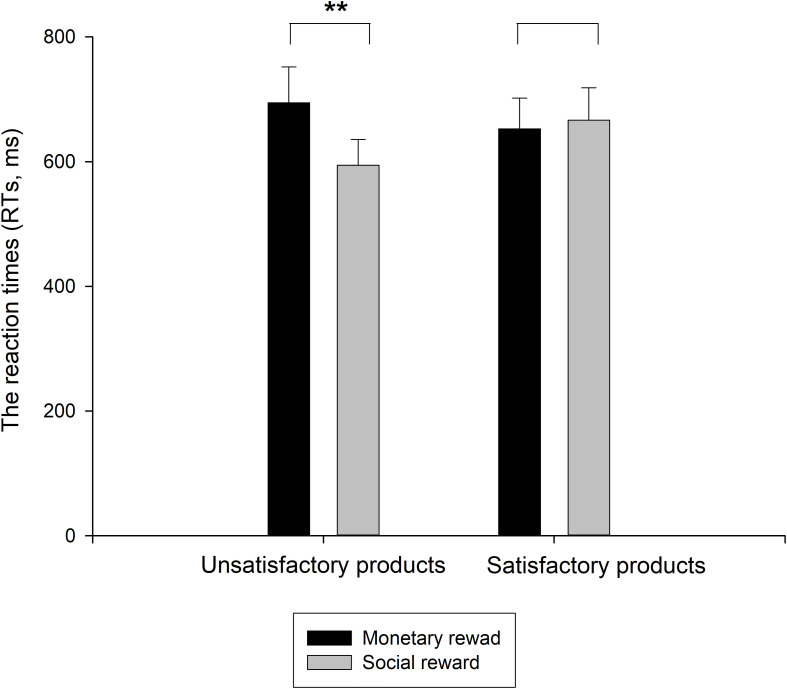
Mean RTs to the monetary and social rewards sorted by product customer satisfaction as satisfactory products and unsatisfactory products. Error bars indicate the SE of the RT. **p < 0.01.